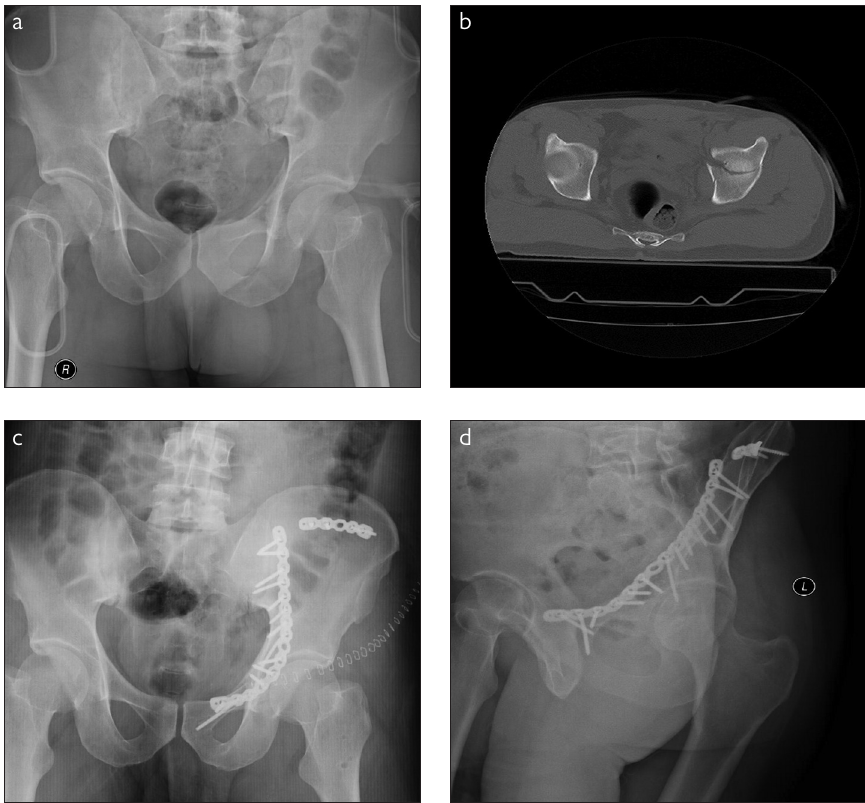
Figure 2. a-d. Anterior column fracture after falling from a height was present in a 41-year-old male patient. The patient was operated on the 5th day after trauma with an ilioinguinal approach. The postoperative reduction was assessed as an anatomical reduction (c). The outcome at 1st-year follow- up was assessed as radiologically (d) and functionally perfect. Postoperative x-ray and CT